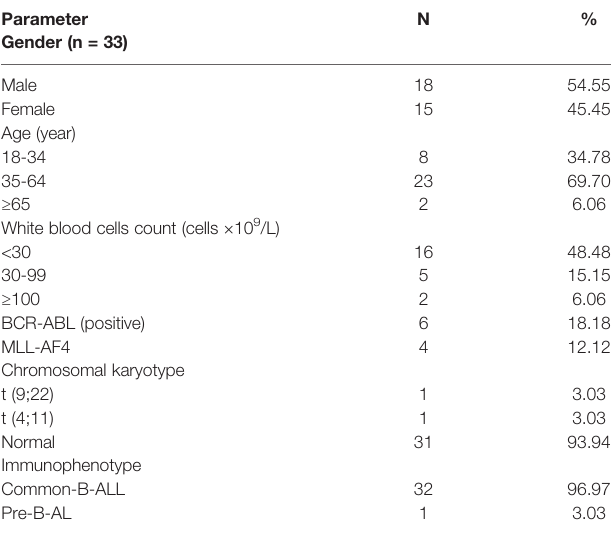
TABLE 1 | The patients with B-ALL samples